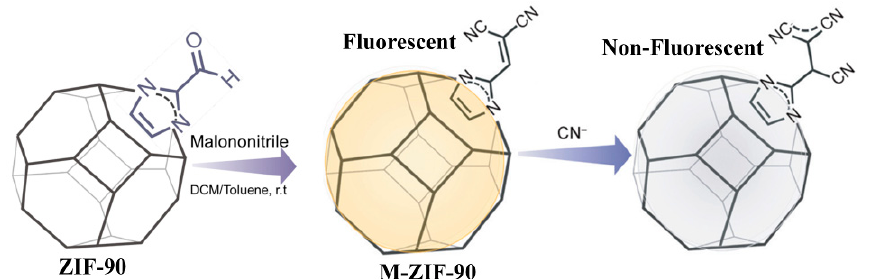
Figure 22. Schematic illustration of the the sysnthesis of M-ZIF-90 and the sensing process for CN − . Reproduced with permission from [166]. Copyright Wiley-VCH, 2016.